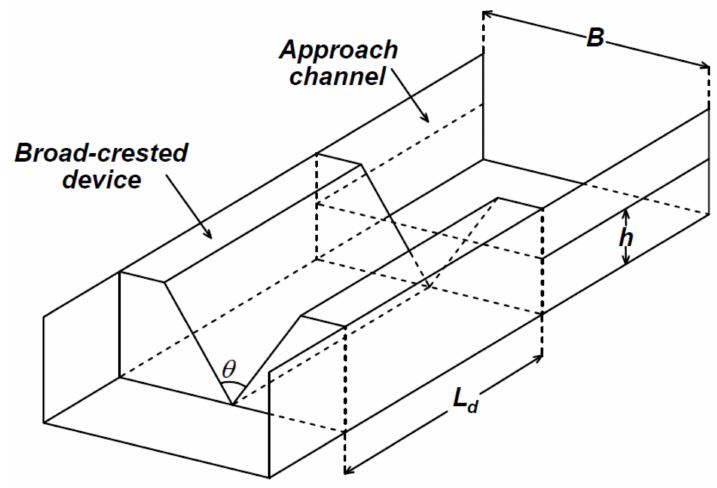
Figure 2. Scheme of the triangular broad-crested weir placed in a rectangular channel used by Achour and Amara [21].